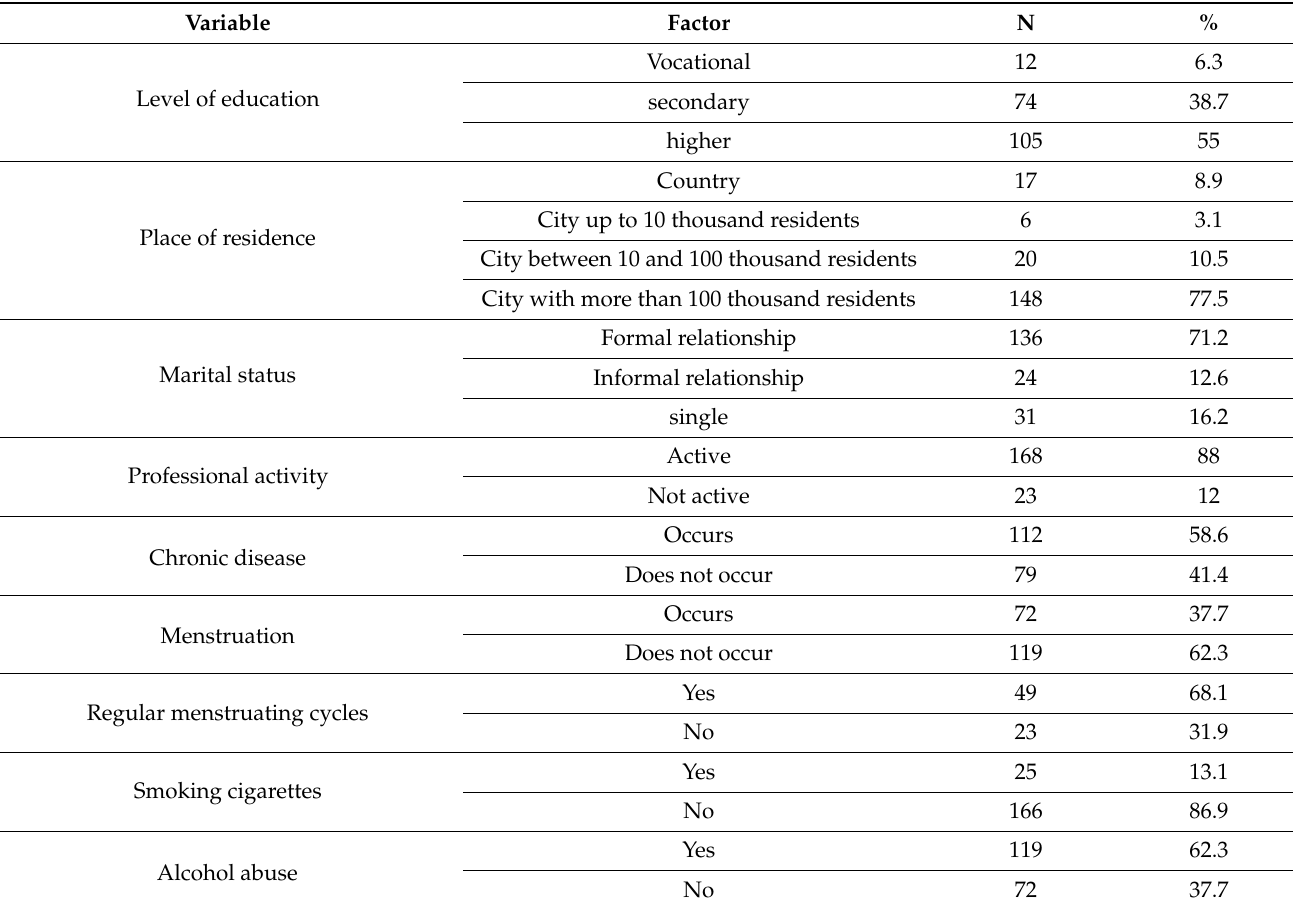
Table 1. Characteristics of the study group considering the sociodemographic factors, smoking tobacco, alcohol consumption, and biological factors.